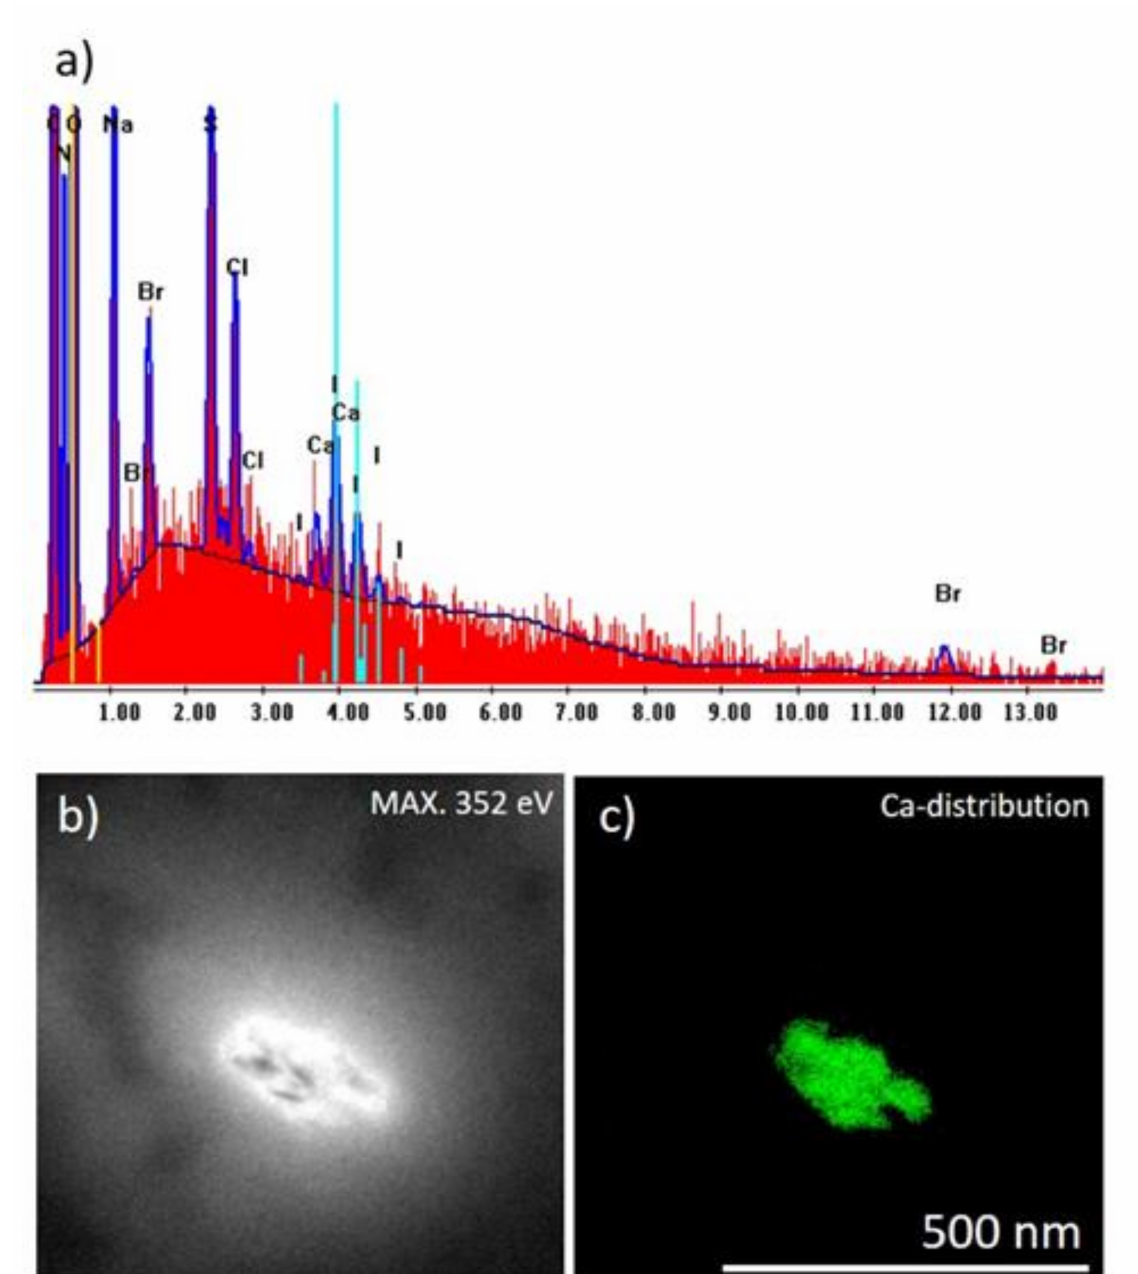
Figure 4. ( a ) EDS analysis of the I. basta skeletal fiber washed with distilled water demonstrating the atomic composition of this structure; ( b ) bright-field image of corresponding TEM image and ( c ) Ca distribution within the corresponding sample visualized in green color (colorization provided by the software to highlight electron diffraction signals of Ca